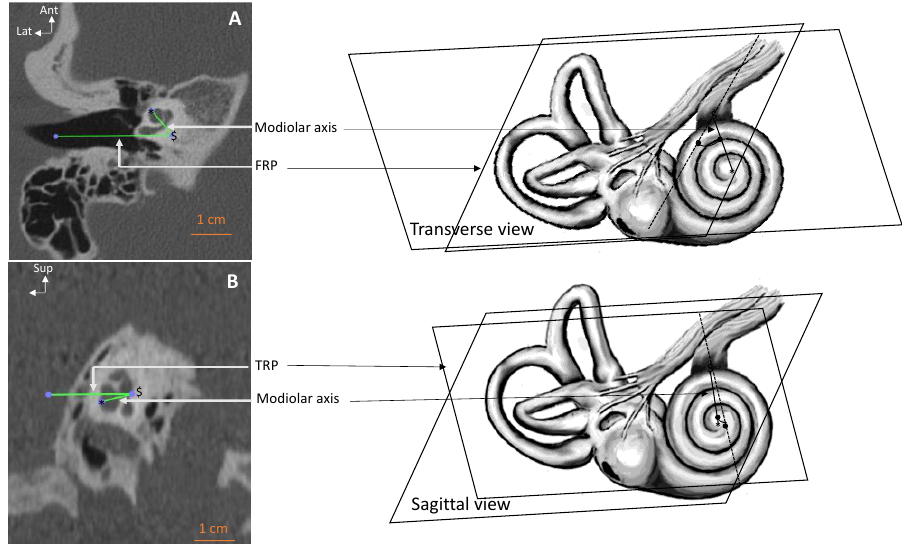
Figure 1. Measurement of the modiolar angle in the transverse ( A ) and the sagittal views ( B ). The axis of the modiolus was defined by a line passing from the cochlear apex (*) to the cochlear fossa in internal auditory meatus ($). FRP: frontal reference plane. TRP: transverse reference plane.